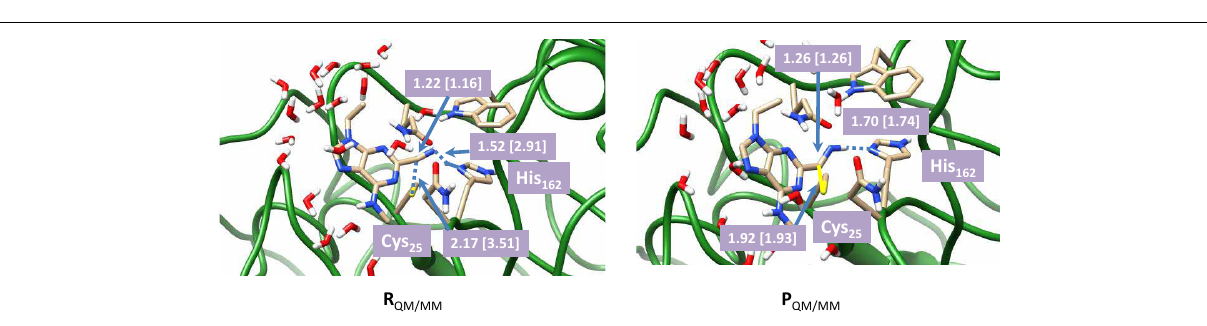
Frontiers in Chemistry | Theoretical and Computational